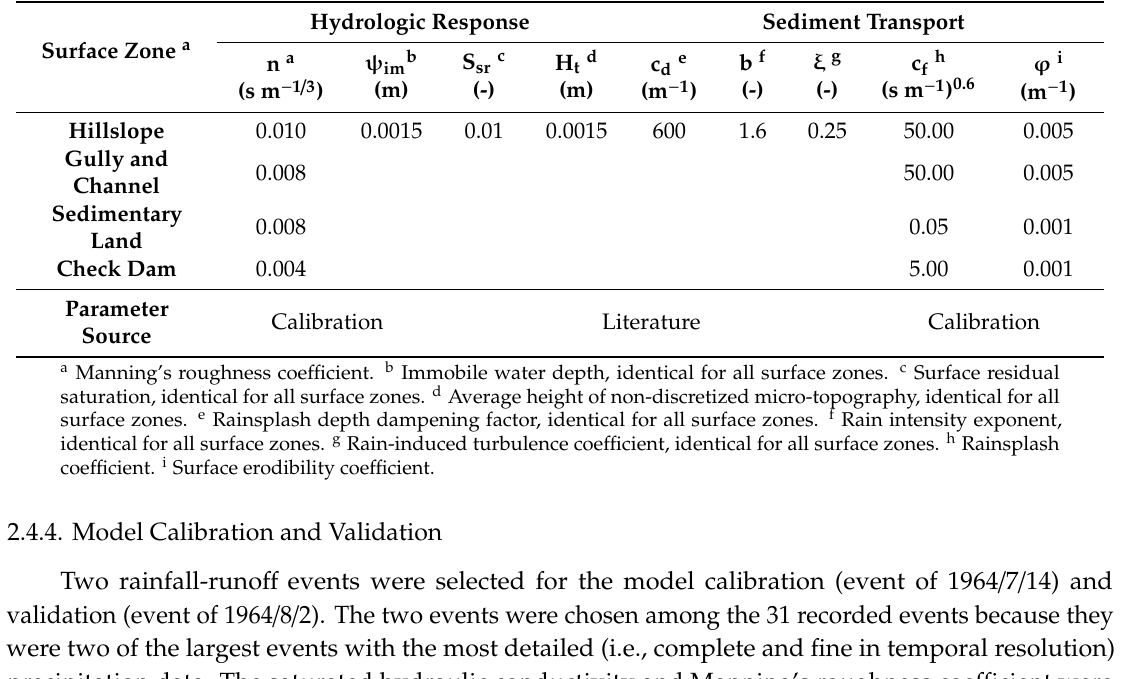
Table 4. Surface parameters used in InHM for the four